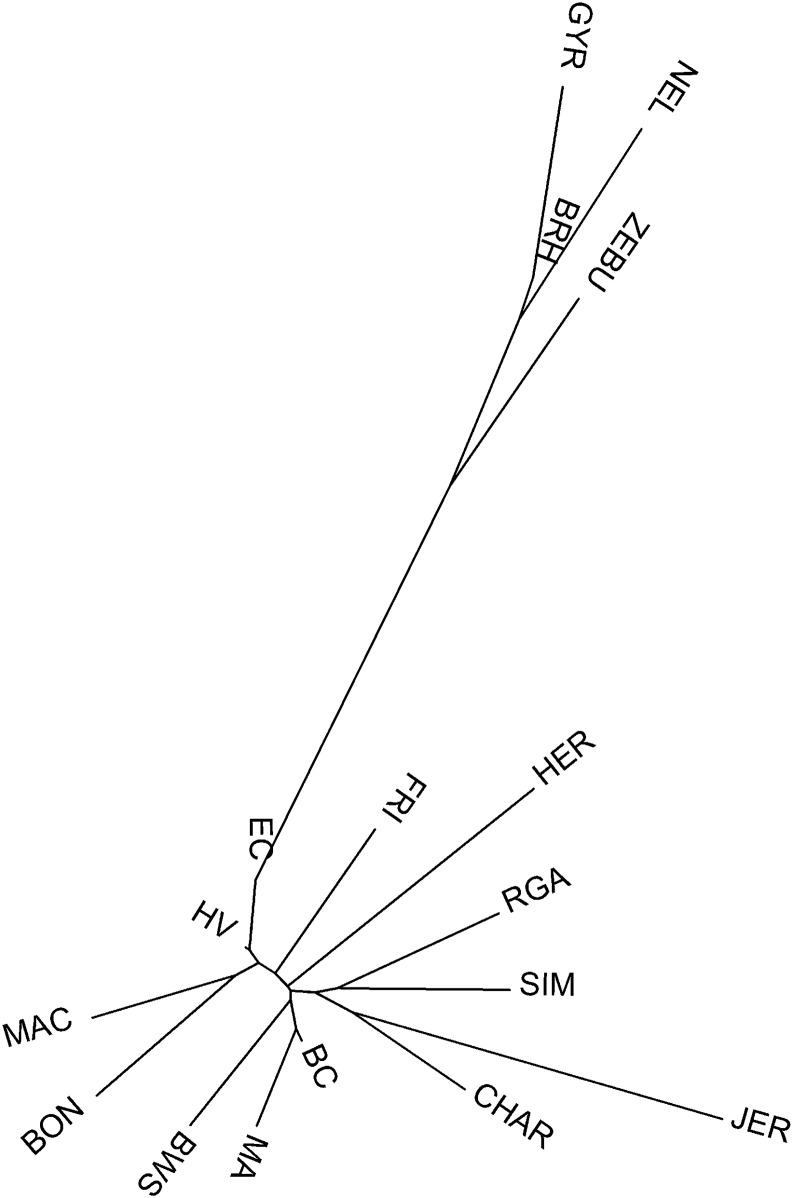
Neighbor-joining dendrogram constructed from the Reynolds genetic distances between 17 cattle breeds.EC: Ecuadorian Creole Ecuadorian of Southern; HV: Hartón del Valle; FRI: Holstein Friesian; BON: Blanco Orejinegro; MA: Marismeña; BC: Berrendaen Colorado; BWS: Brown Swiss; SIM: Simmental; HER: Herford; CHAR: Charolais; JER: Jersey; RGA: Rubia Gallega; MAC: Macabea; ZE: Zebu; NEL: Nellore; BRH: Brahman; GYR: Gyr.